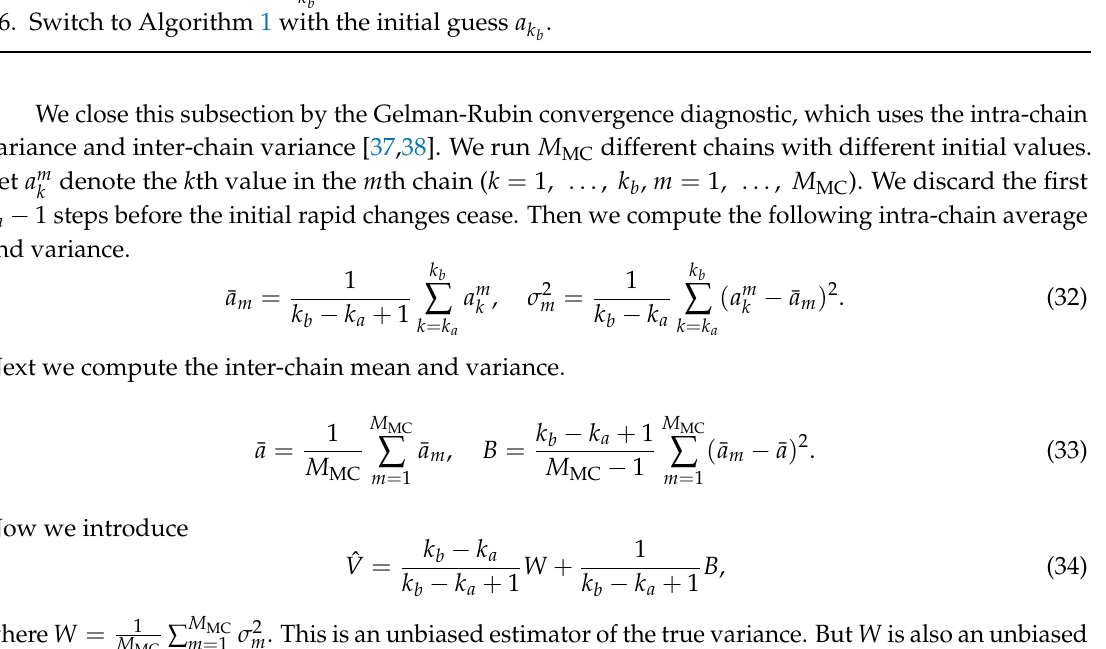
Figure 1. The function q ( t k ) is the instrument response function divided by the maximum value of the measured reflected light. The peak of q is at 2.56 ns. { U } 11 k = y 11 k is the measured reflected light normalized by its maximum value. In the lower panel of Figure 1, t 1 and t M dashed lines. The size of the phantom is large enough that we can assume the three-dimensional